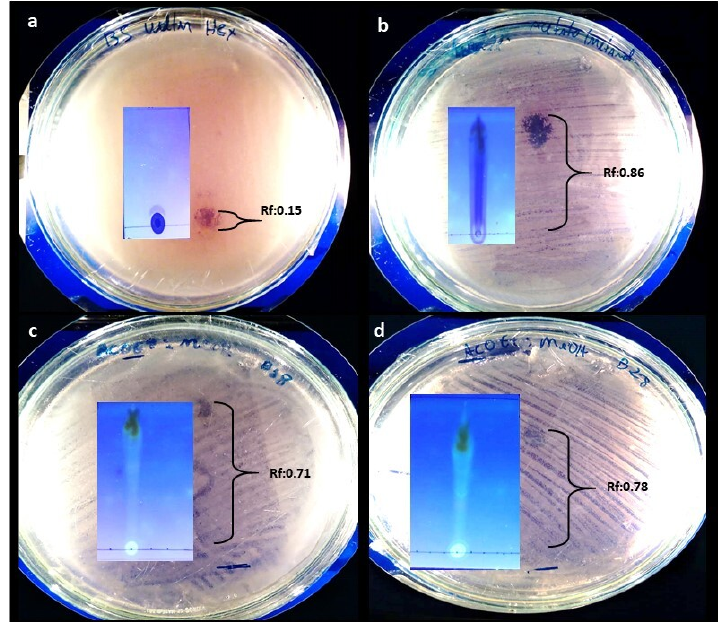
Figure A2. Mobile phase, main bands and the Rf value of the bands that were associated with antibacterial activity against E. coli ATCC 25922. A. stygium WL1B5 – Hex 100% ( a ), MeOH 100% ( b ); C. rosea WL5B18—EtOAc/MeOH 1:1 v/v ( c ); C. rosea WL8B28—EtOAc/MeOH 1:1 v/v ( d ).